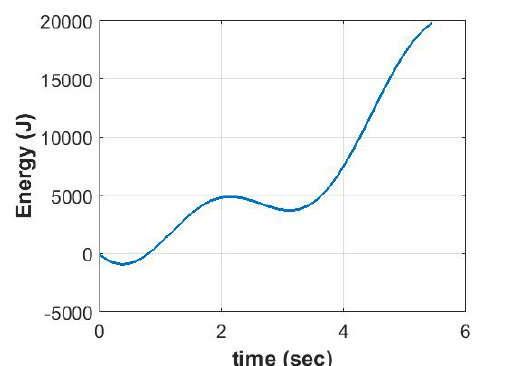
Figure 7. The harvested energy over time for one cycle for Case Study